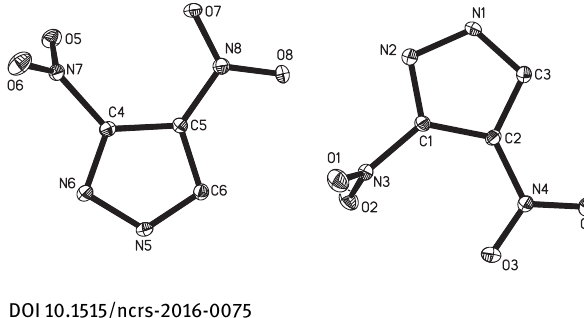
Table 1: Data collection and handling.